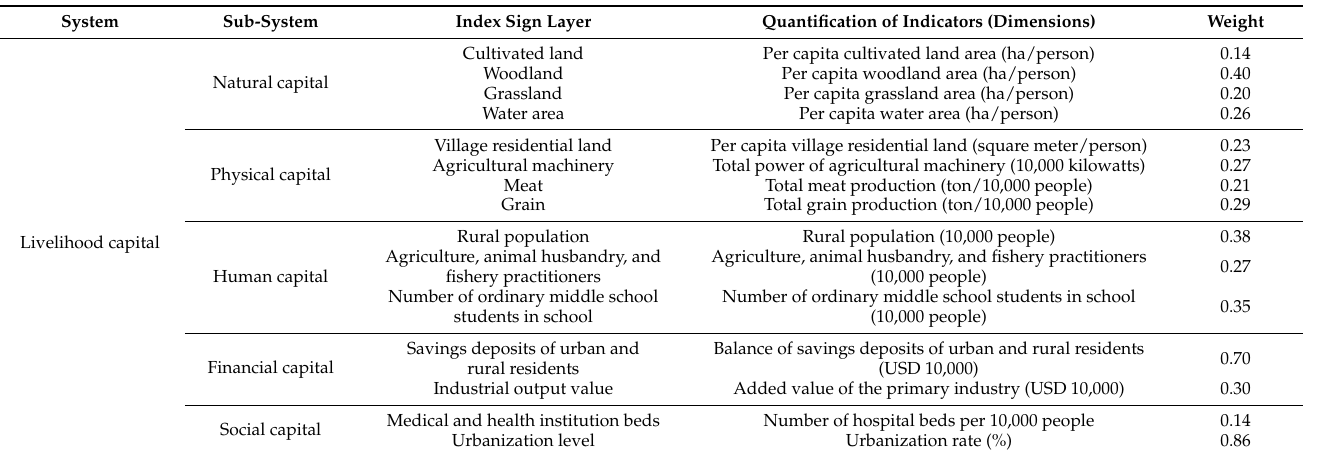
Table 1. Measurement of livelihood capital in the